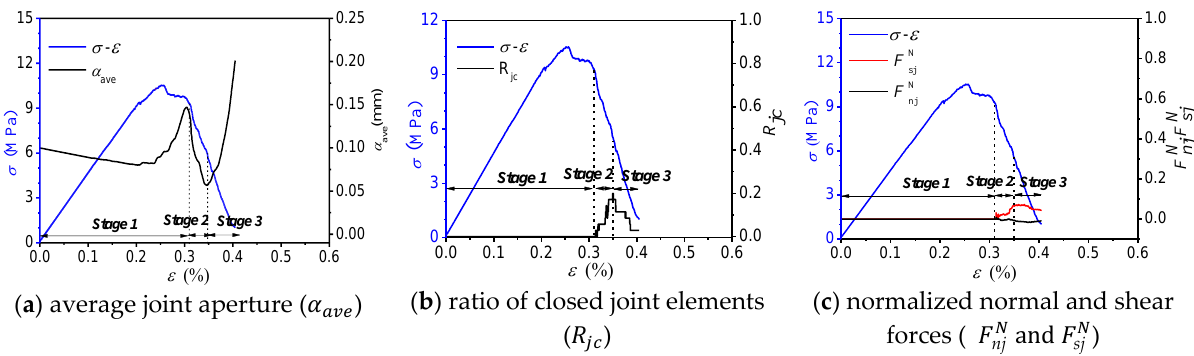
Figure 15. Evolution of the parameters of the joint system with increasing axial strain ( 𝛽 =60°).